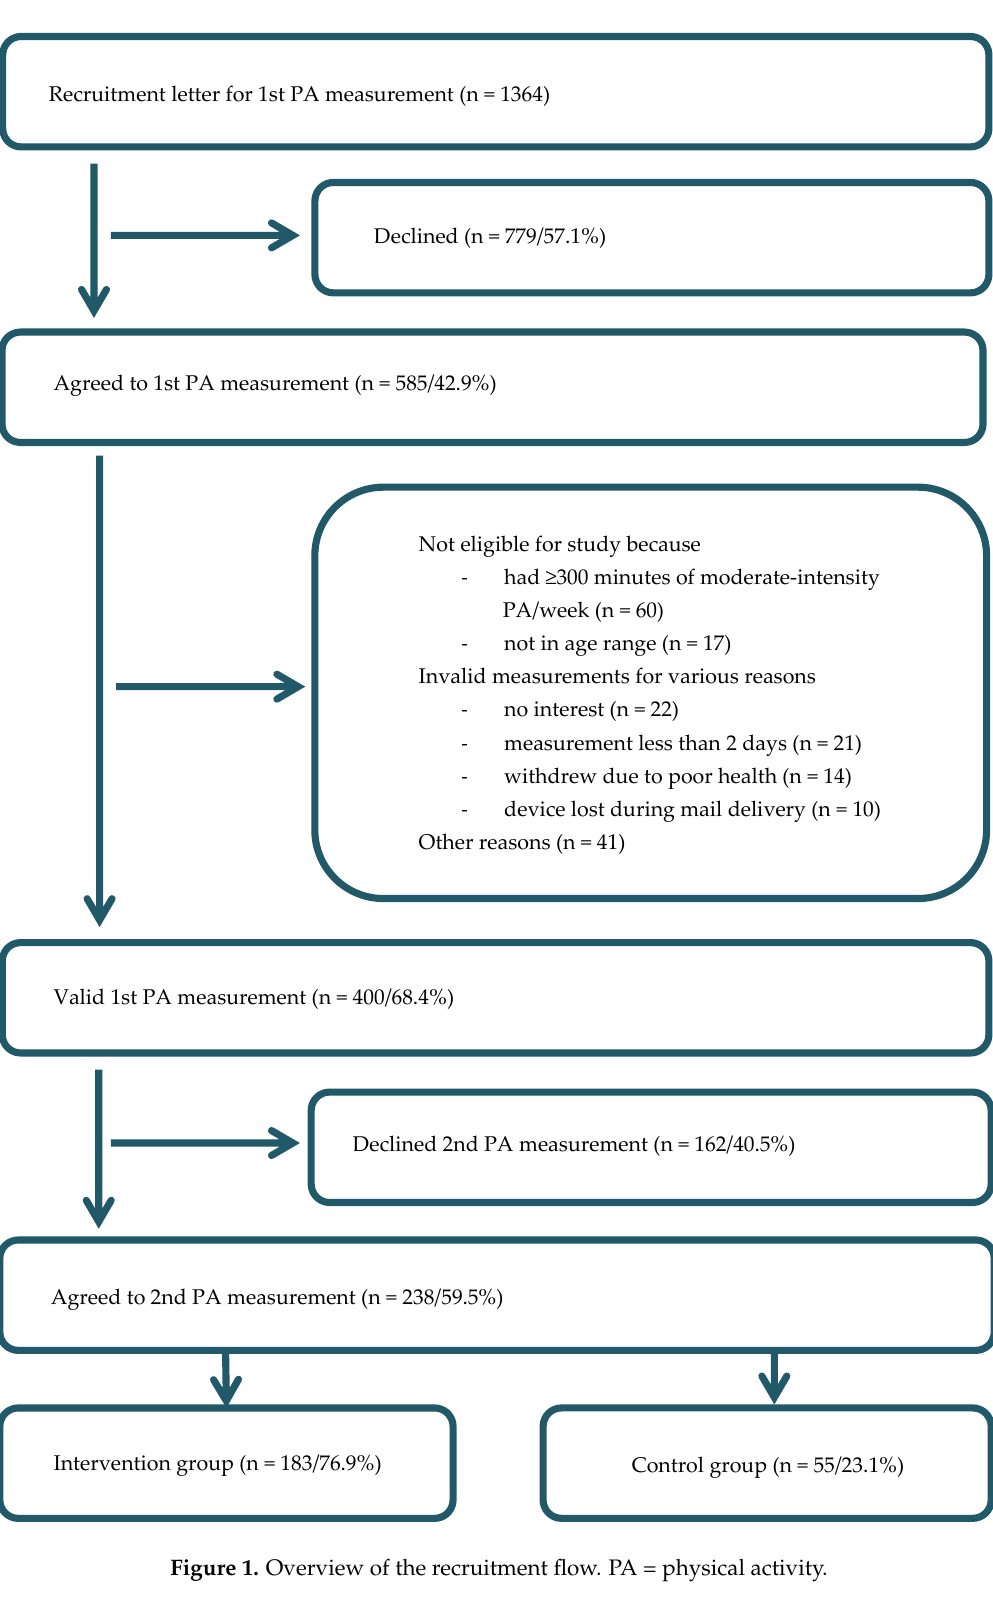
Figure 1. Overview of the recruitment flow. PA = physical